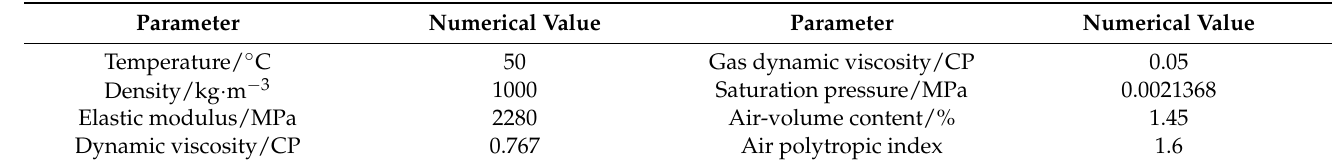
Table 1. Fluid-medium parameter